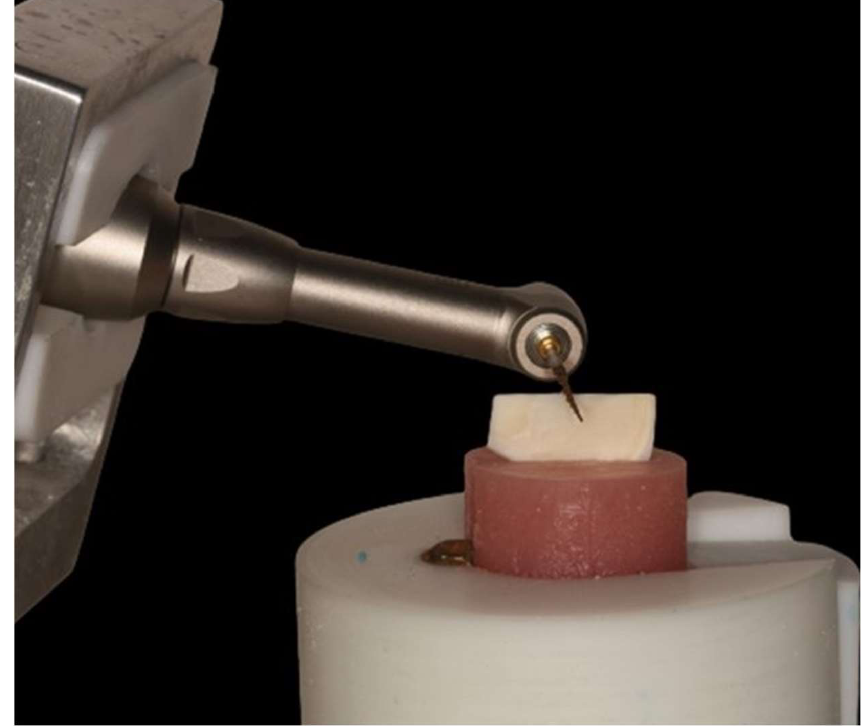
Figure 6. Cutting efficiency testing: engine-driven system placed in a perpendicular position to the tested specimen.